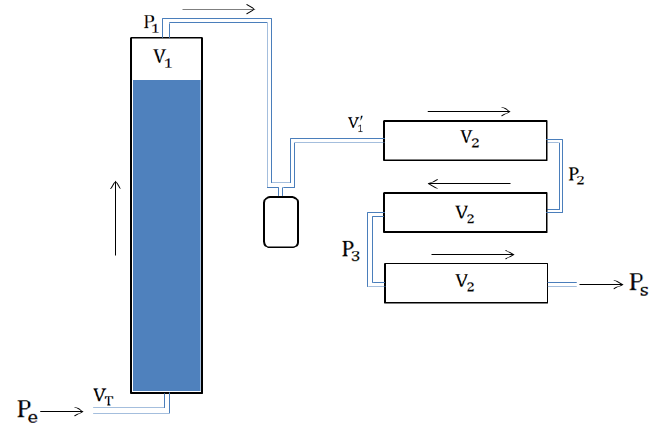
Figure 2. 2D view of the purification system.